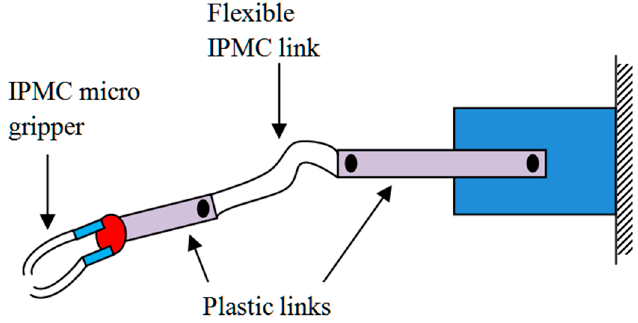
Figure 15. Flexible link manipulator.